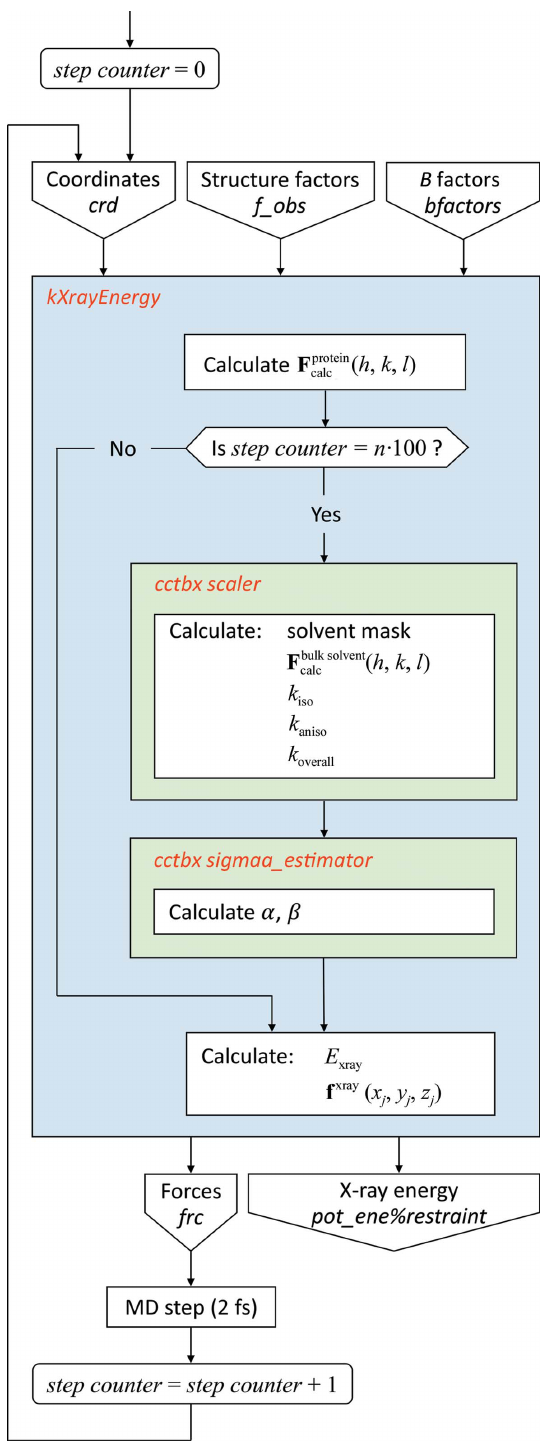
Figure 1 Flowchart illustrating the functionalities and interactions of the new Amber module kXrayEnergy